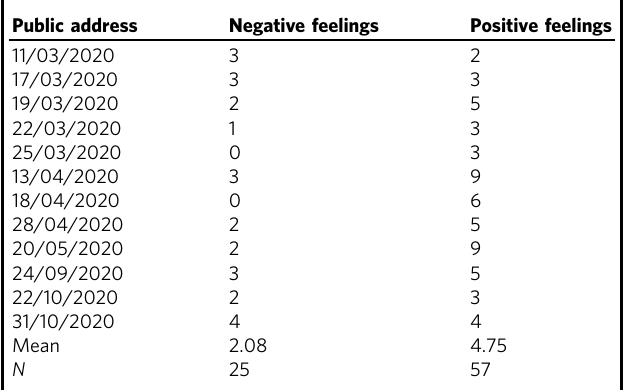
Table 6 Evocation to positive and negative feelings.